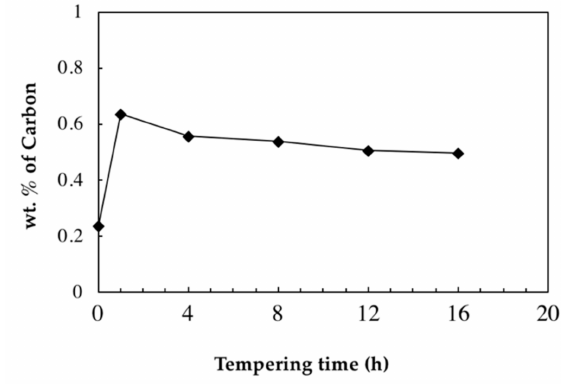
Figure 5. Change in carbon content of retained austenite during tempering at 550 ◦ C.